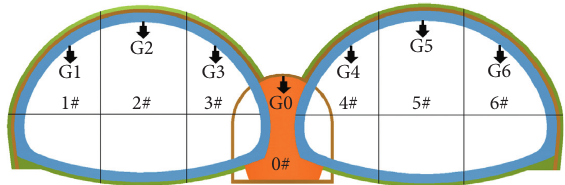
Figure 11: Layout of monitoring points in double-arch